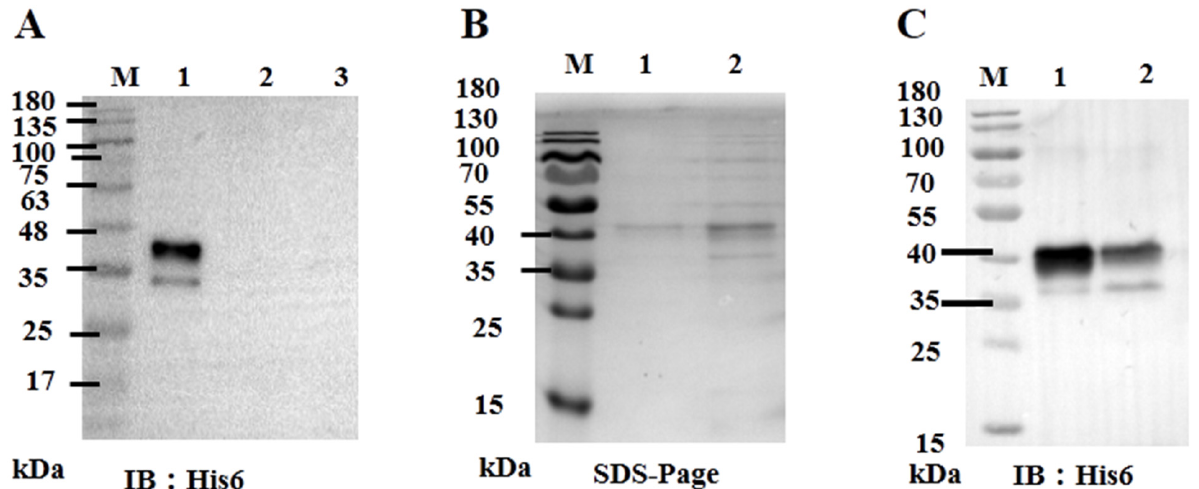
Figure 3. Expression of ORF59 protein in Sf9 cells. ( A ) Western blotting analysis of ORF59 in recombinant baculovirus-infected Sf9 cells. Total cell lysates collected at 72 hpi with recombinant baculovirus were analyzed using Western blotting, and the anti-His6 tag antibody was used to probe the His6-tagged fusion protein ORF59. Lane: 1, Lysates from sf9 cells infected with recombinant baculovirus; Lane: 2, Lysates from sf9 cells infected with control baculovirus; Lane: 3, Sf9 cell lysates. ( B ) SDS-PAGE of expressed and purified tagged fusion protein ORF59. Lanes: 1 and 2, purified fusion protein. ( C ) Western blotting analysis of the expressed and purified tagged ORF59 fusion protein. Lane: 1, purified fusion protein; Lane 2, nonpurified fusion protein. Protein size markers are indicated (lane M). SDS-PAGE, sodium dodecyl sulfate polyacrylamide gel electrophoresis; hpi, hours post ‐ infection.